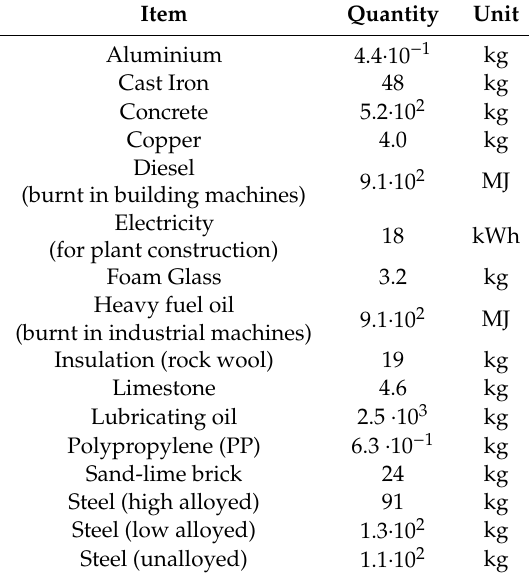
Table A4. Foreground inventory of life-cycle inputs for adiabatic compressed air energy storage (A-CAES) technology, including plant construction, compressors, thermal energy storage (TES) and heat expanders. All values are per MWh of electricity storage